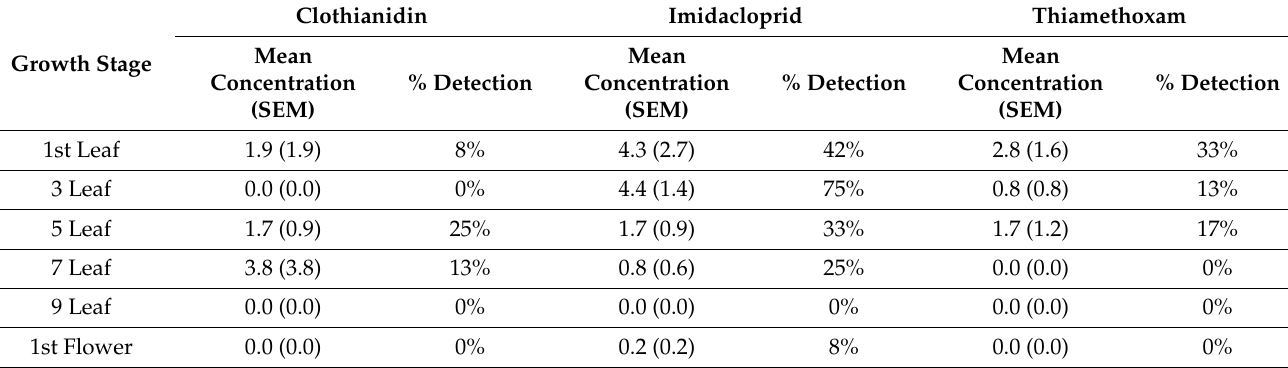
Table A3. Mean concentration (ng/g) and percent detection detected in cotton leaf tissue from untreated plots at each sampled growth stage across all locations.